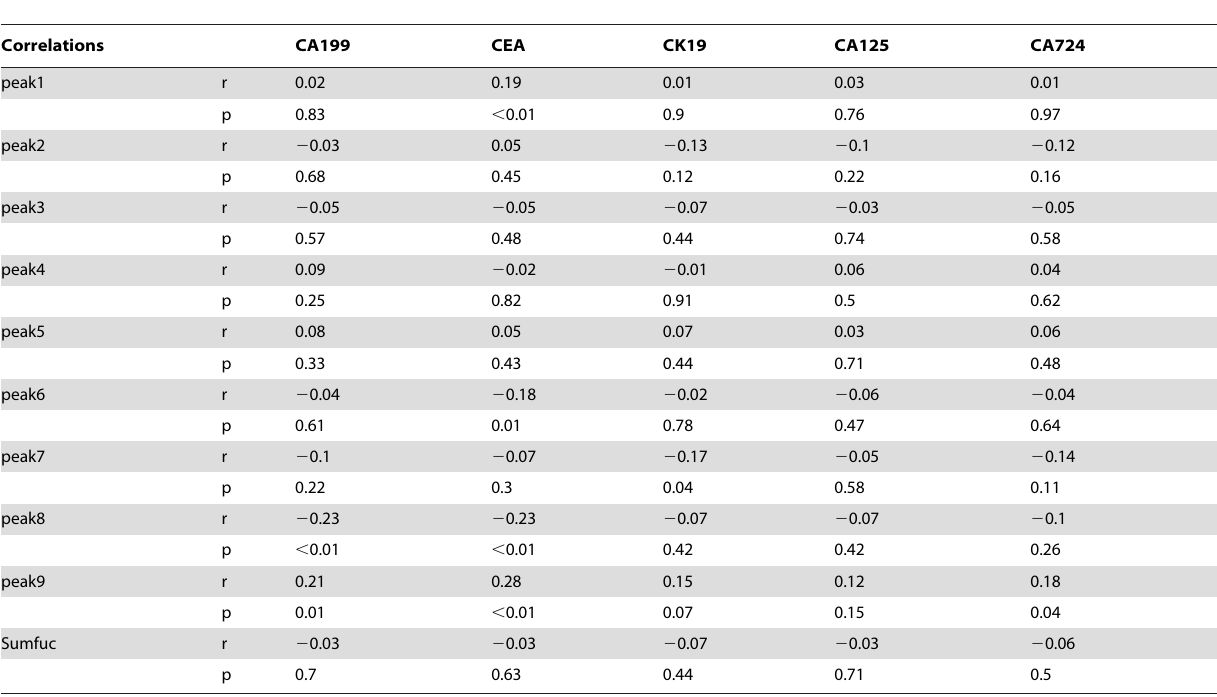
Table 4. Correlation analysis between N-glycans and routine tumor markers of gastric cancer.